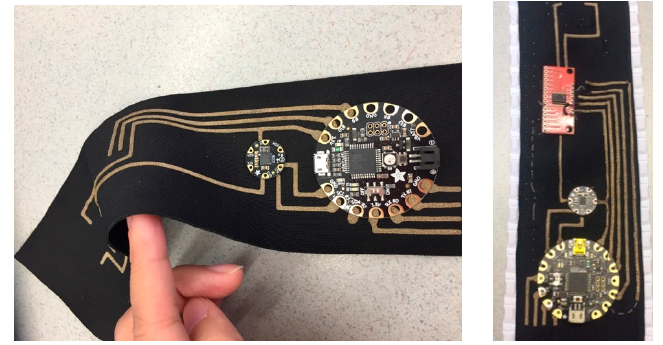
Figure 5. Conductive textile-based flexible traces.